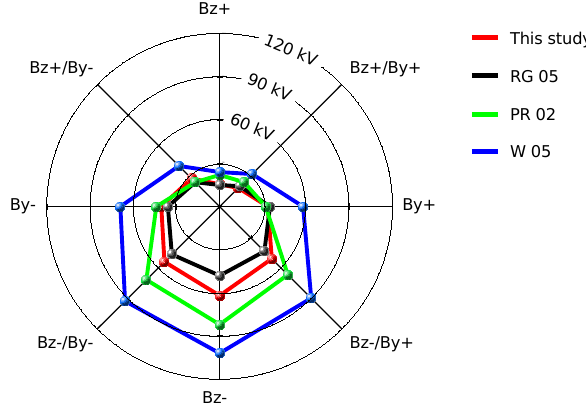
Fig. 9. Illustration of the Northern Hemisphere polar cap potentials as function of IMF direction from various studies. The values of the present study (red curve) fall in-between or overlap those obtained by Ruohoniemi and Greenwald (2005, black curve) and Papitashvili and Rich (2002, green curve), but are consistently lower than the values of Weimer (2005, blue curve). The clock-angle dependency, with the highest potentials for southward IMF, is clearly apparent from all these